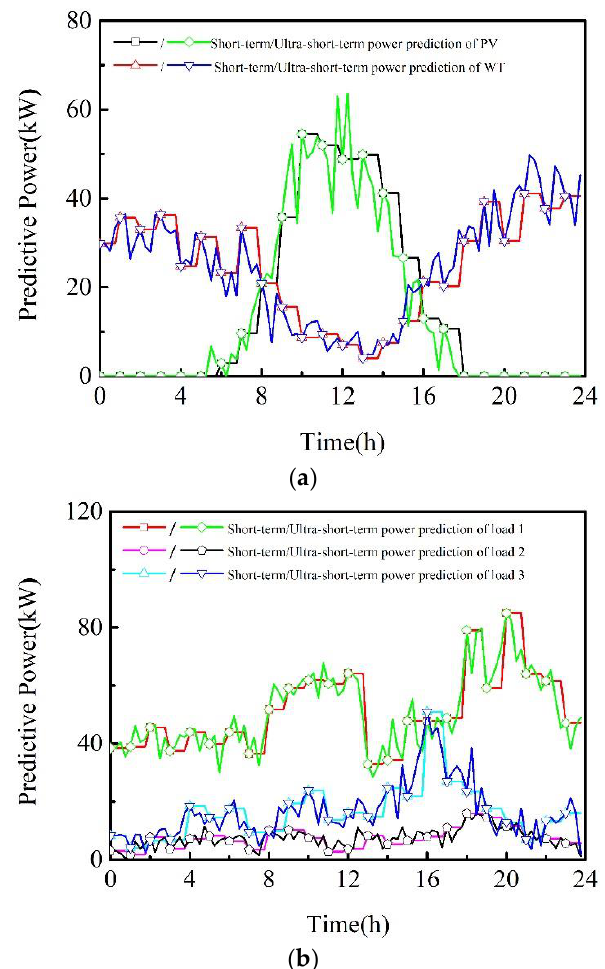
Figure 4. Short-term and ultra-short-term power prediction results. ( a ) Prediction results of RES. ( b ) Prediction results of load.